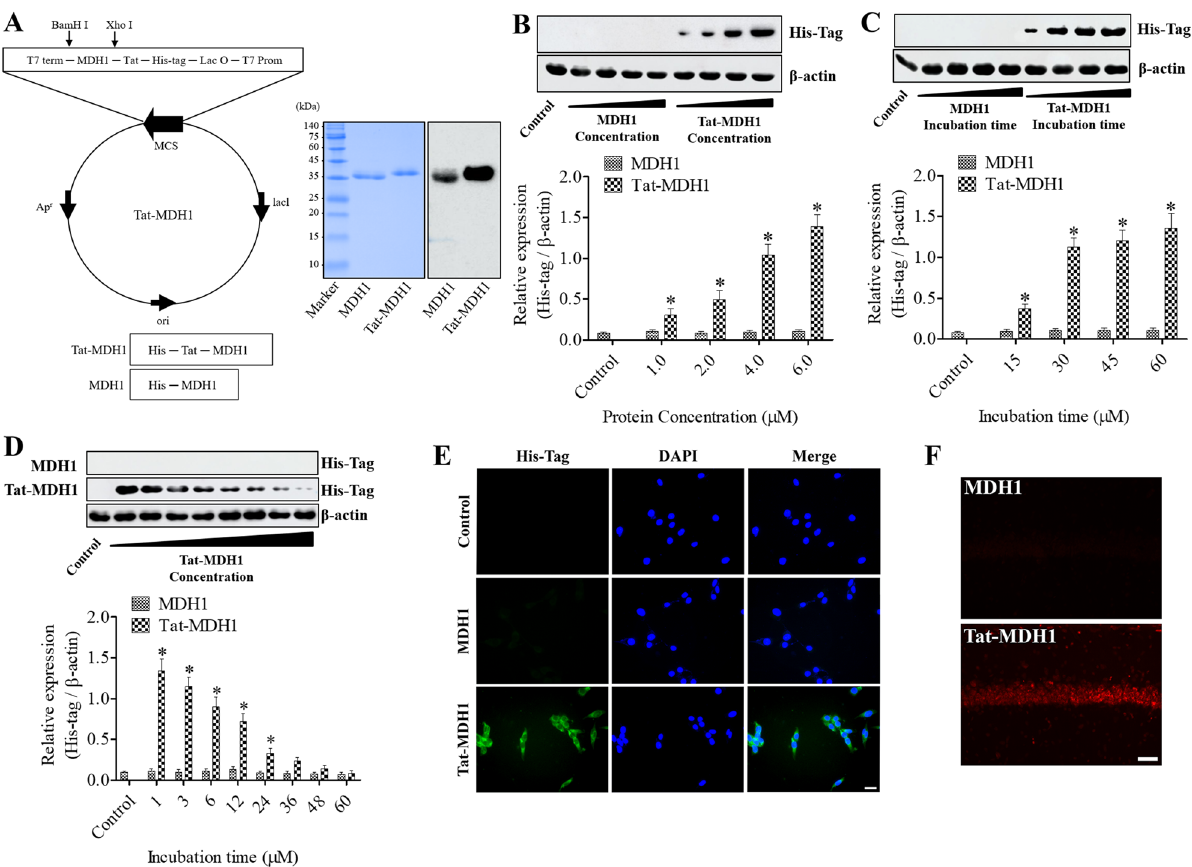
Figure 1. Validation of Tat-MDH1 delivery into HT22 cells and the gerbil hippocampal CA1 region. ( A ) Tat- MDH1 was designed with His-tag and MDH1 with or without the Tat expression vector. After purification, the expression of Tat-MDH1 was confirmed by Coomassie brilliant blue staining and western blotting for His-tag. ( B ) HT22 cells were incubated for 1 h after various concentration (1.0–6.0 μM) of Tat-MDH1 and MDH1 treatments. ( C ) HT22 cells were incubated for various lengths of time (15–60 min) after 4.0 μM of Tat-MDH1 and MDH1 treatments. ( D ) Tat-MDH1 (4.0 μM) and MDH1 (4.0 μM) were added to HT22 cells and harvested for various incubation time (1–60 h). Delivered proteins were detected by western blot analysis for His-tag. All assays were performed in triplicate. Data are expressed as mean + standard deviation and were analyzed using Student’s t -test ( B and C ) and one-way analysis of variance followed by Tukey’s multiple comparison post hoc test ( D ) (n = 5, * p < 0.05, significantly different from the control group). ( E and F ) Transduced proteins were visualized by immunochemical staining for His-tag at 1 h after 4.0 μM Tat-MDH1 treatment in HT22 cells and at 6 h after 1 mg/kg Tat-MDH1 treatment in the gerbils, respectively. Scale bar = 20 μm ( E ) and 50 μm ( F